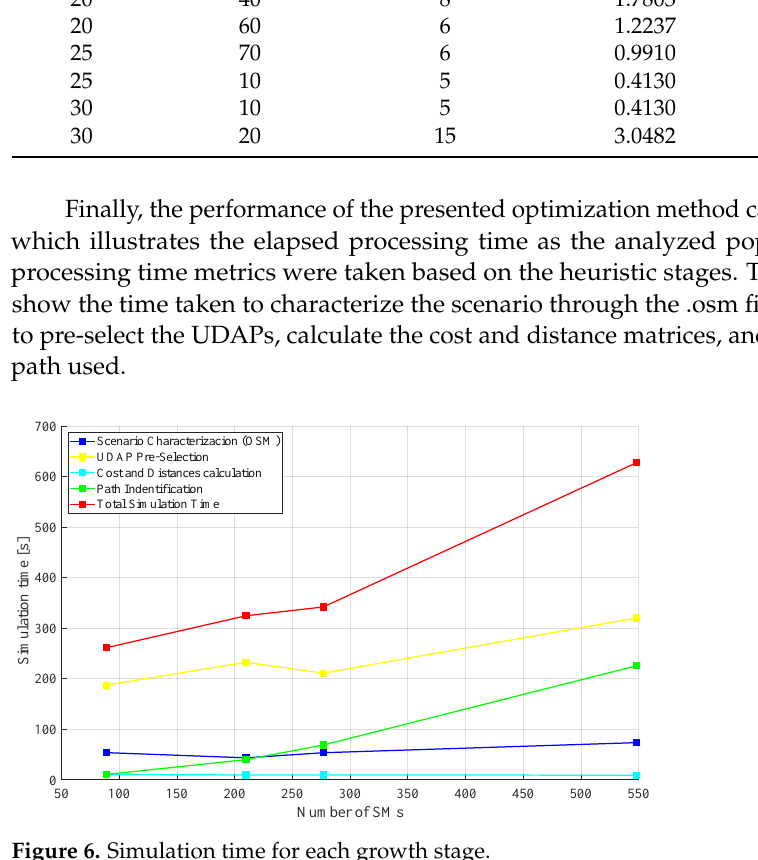
Figure 6. Simulation time for each growth